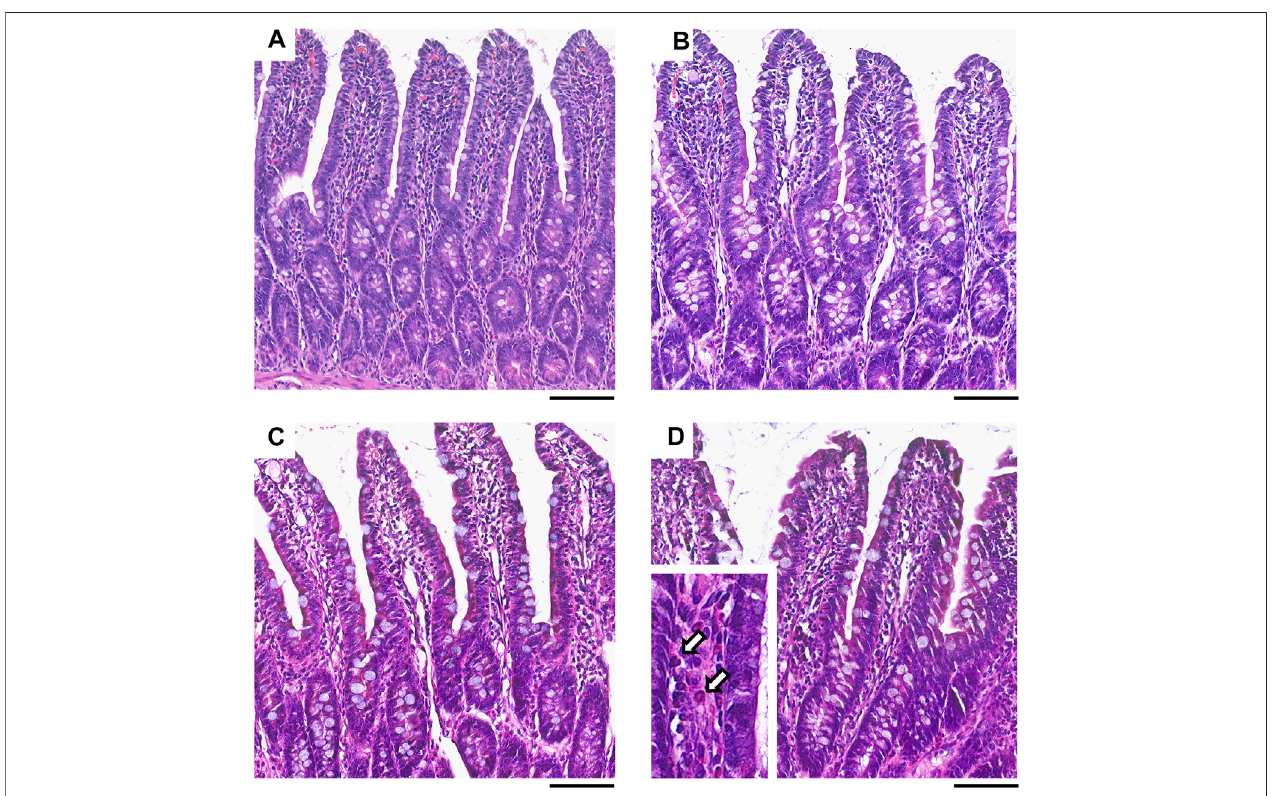
FIGURE 2 | Representative histological micrographs of the distal jejunum of rats treated with vehicle (A) , or ketorolac at doses of 1 (B) , 3 (C) and 10 mg/kg (D) for four weeks (scale bar: 100 μ M, hematoxylin and eosin staining). White arrows point to neutrophil granulocytes, indicating increased cellularity of the lamina propria.